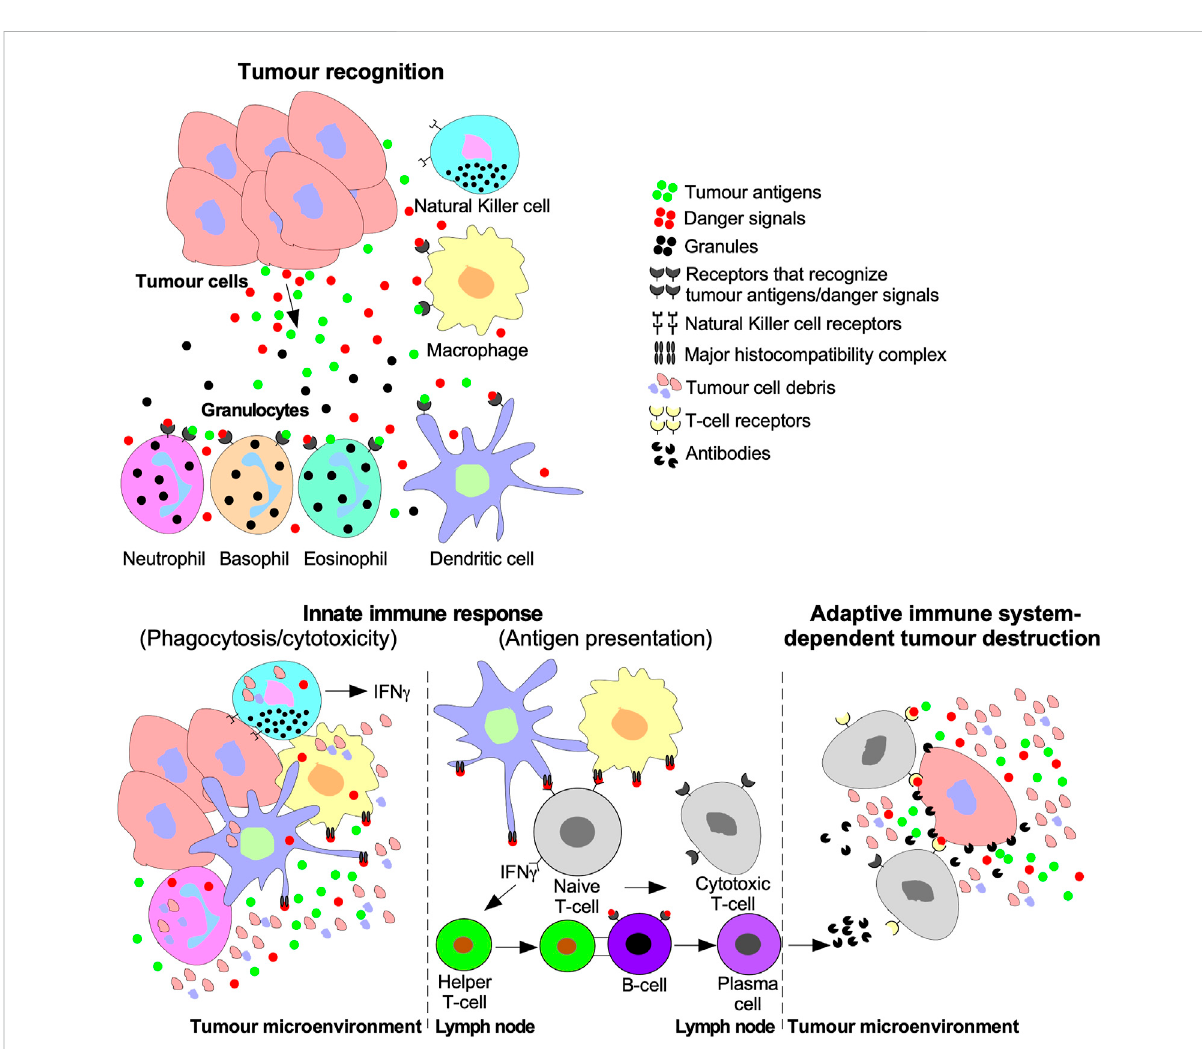
FIGURE 5 Tumour recognition and destruction mediated by the innate and adaptive immune systems. Tumour cells release antigens and danger signals that serve as a chemotactic gradient to recruit cells of the innate immune system ((Natural Killer (NK) cells, macrophages, dendritic cells, and granulocytes (neutrophils, basophils, and eosinophils)). Cells of the innate immune system may destroy tumours using cytolytic/phagocytic functions or activate the adaptive immune system. The adaptive immune system is activated by humoral signals, such as interferon- γ (IFN γ ), which is released by NK cells, dendritic cells, and macrophages. Furthermore, antigen presenting macrophages and dendritic cells deliver tumour antigens using the major histocompatibility complex to Naive T-lymphocytes (T-cells) or B-lymphocytes (B-cells). Naive T-cells are stimulated to differentiate into Cytotoxic T-cells and Helper T-cells. B-cell differentiation into cytotoxic antibody-producing plasma cells is triggered by B-cell receptors binding to Helper T-cells or tumour antigens. The adaptive immune system facilitates tumour destruction via Cytotoxic T-cells releasing enzymes into tumour cells or antibodies produced by plasma